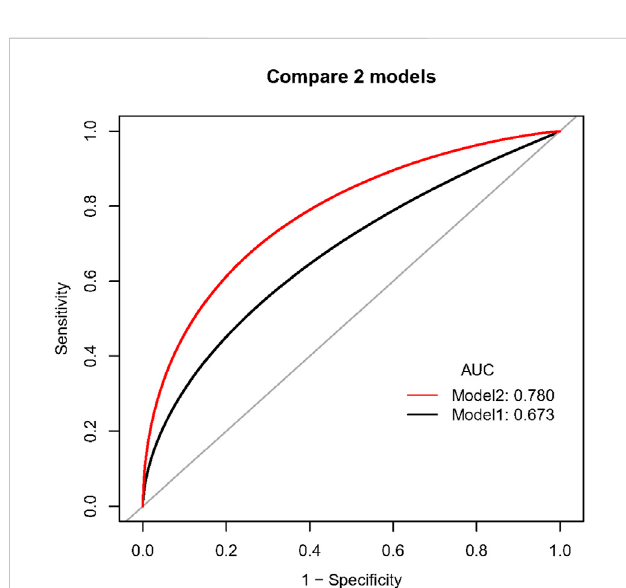
FIGURE 3 Comparison of discriminatory ability between two prediction models in the overall population. Caption: Model 1 included BCT angle, aortic tortuosity, and aortic arch diameter. Model 2 involved the degree ofquestion mark,aorticrootdiameter,aorticwidth,BCTangle,and BCT diameter.